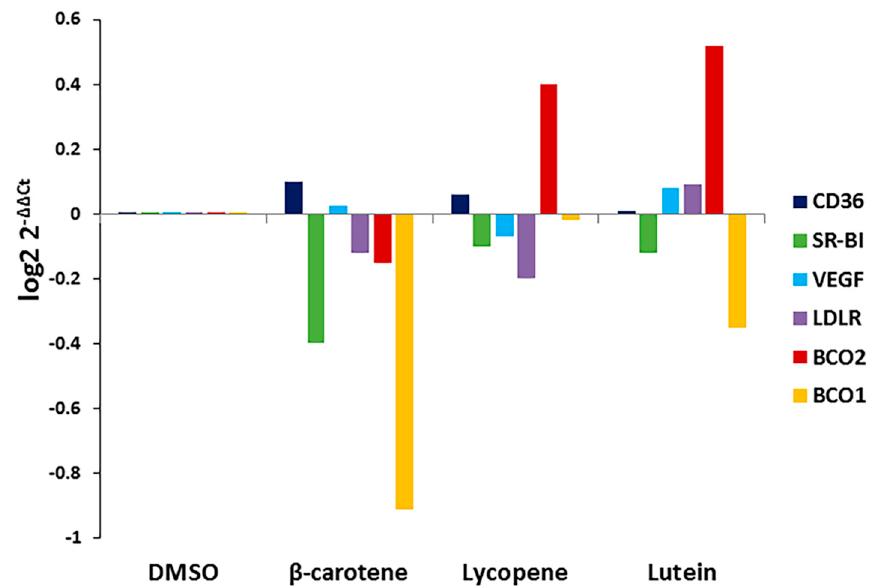
Figure 3. Effects of specific carotenoids on the expression of selected xanthophyll metabolism-related genes in ARPE-19 cells. ARPE-19 cells were treated with 1 µ M concentration of indicated carotenoids for 24 h. Total RNA was isolated and qRT-PCR was performed for indicated genes. Data are shown as expression of fold changes (log 2 2 −ΔΔ Ct ).